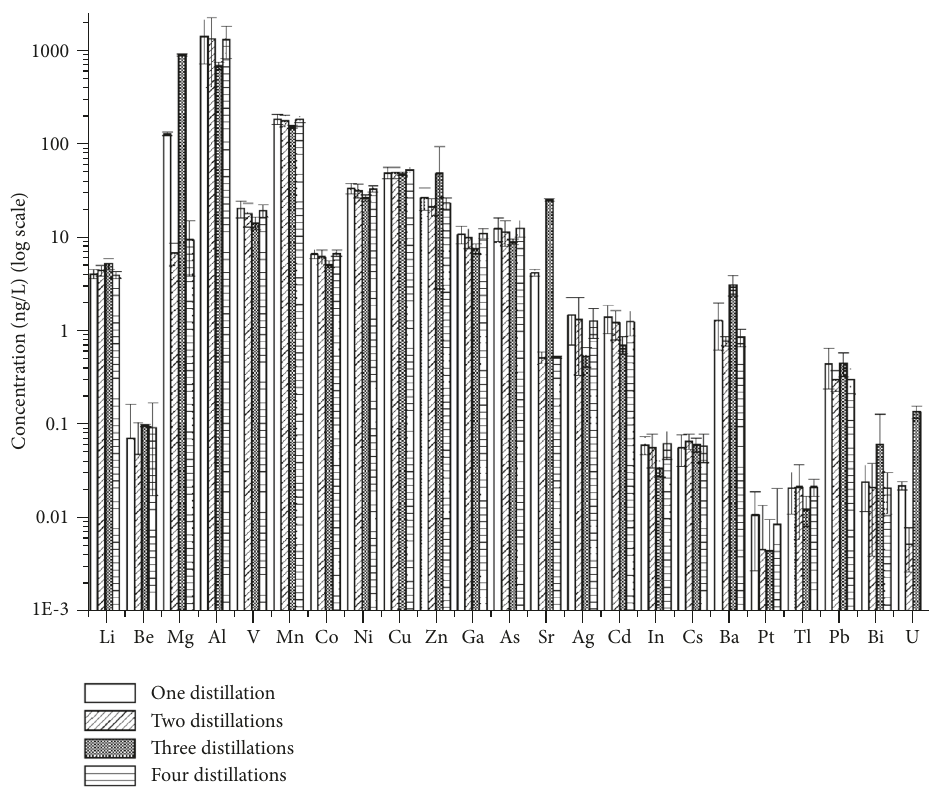
Figure 1: Effect of subsequent distillations on trace element concentrations in HNO 3 (subboiling temperature: 82 ∘ C). Error bars correspond to ± 1 standard deviation based on the four analyzed